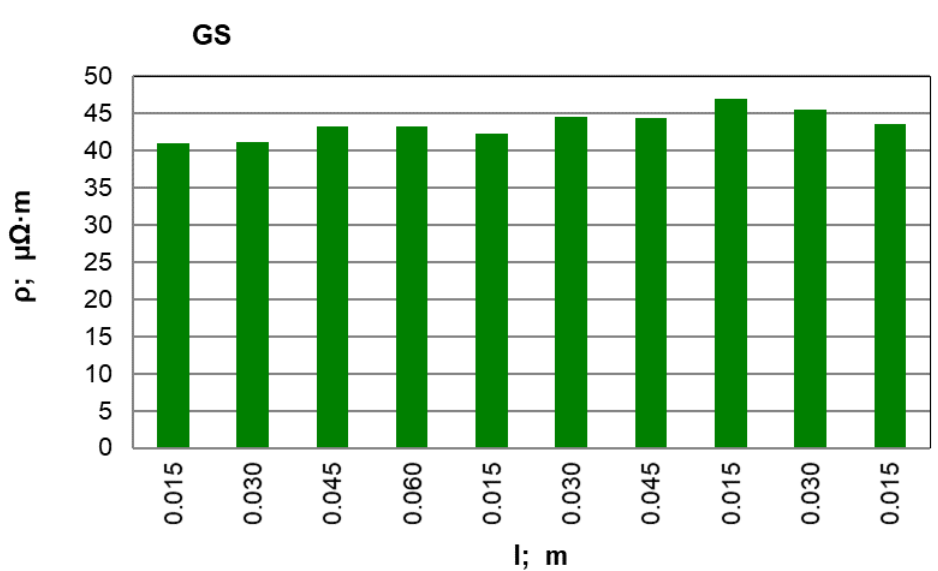
Figure 5. GS material resistivity for various measuring electrode distances l; m.